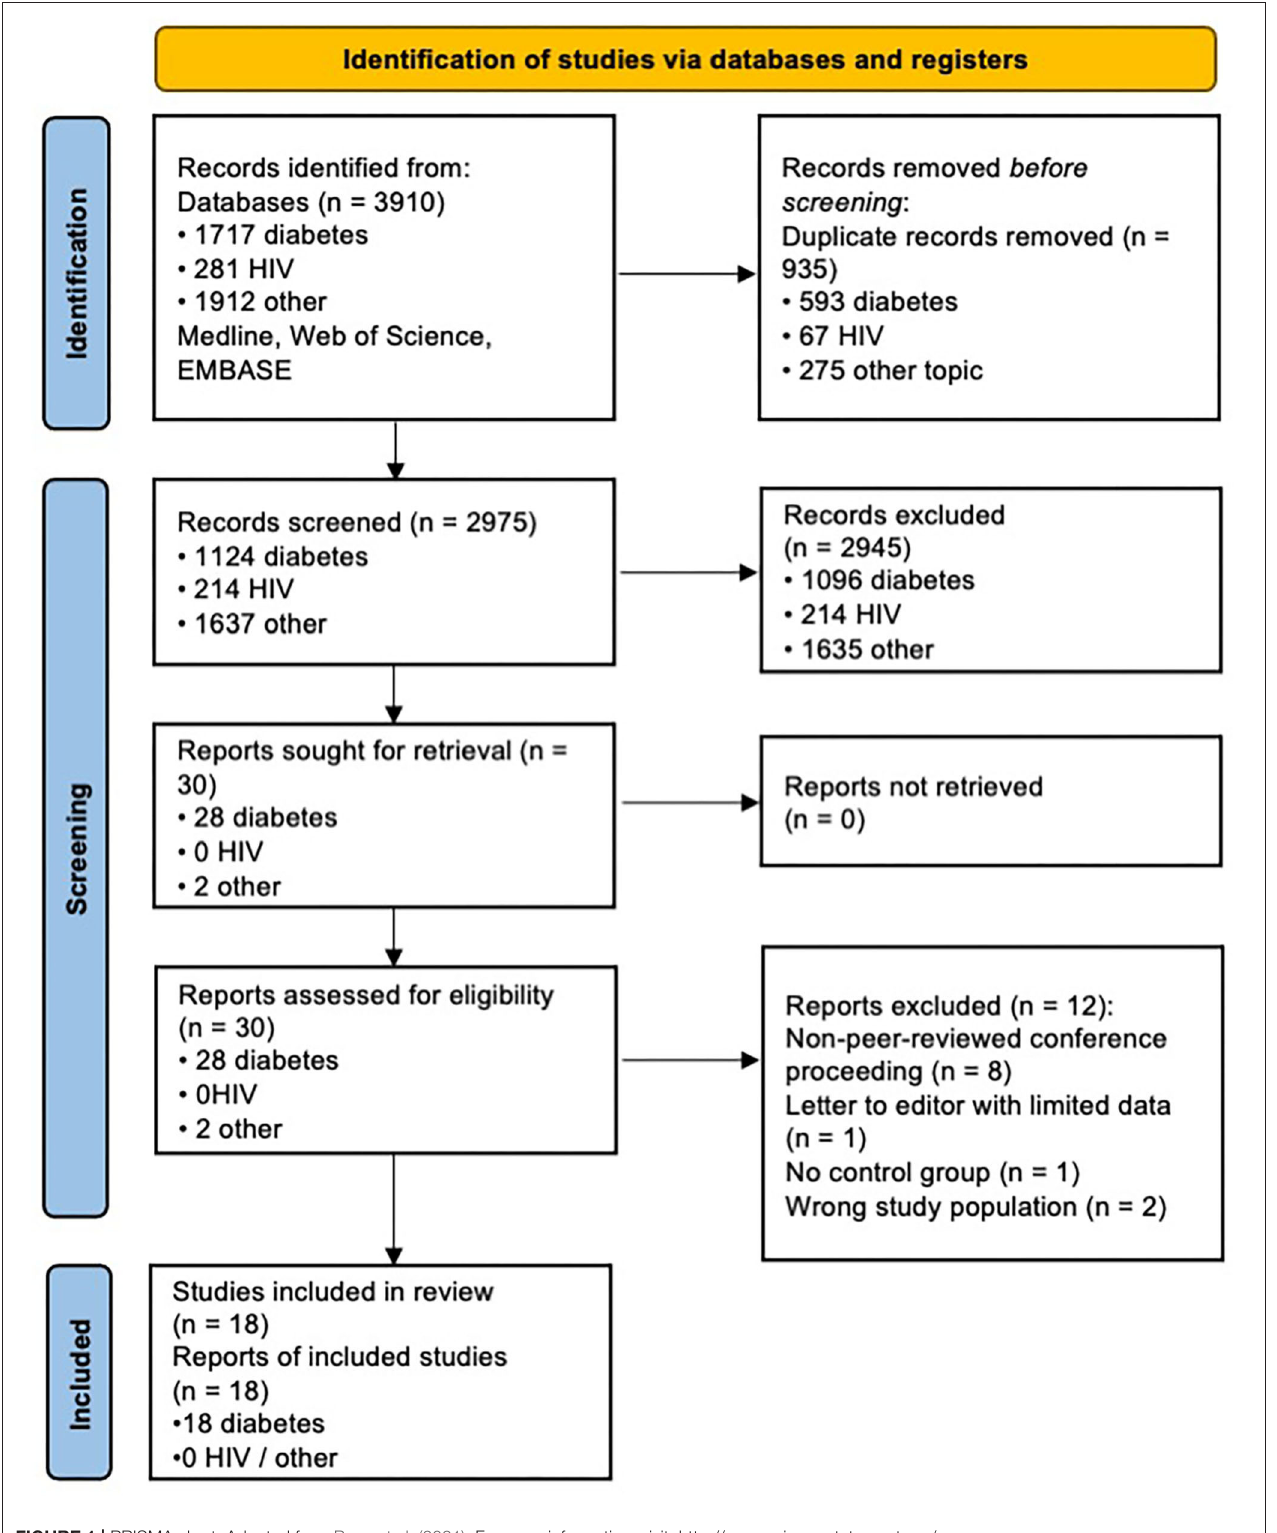
FIGURE 1 | PRISMA chart. Adapted from Page et al. (2021). For more information, visit: http://www.prisma-statement.org/.